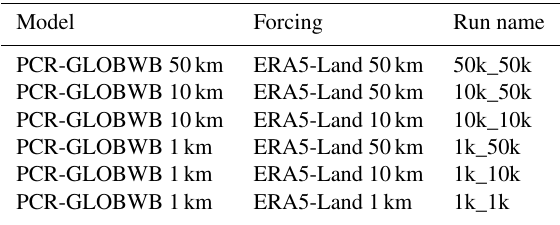
Table 1. Overview of model and forcing in addition to the run names